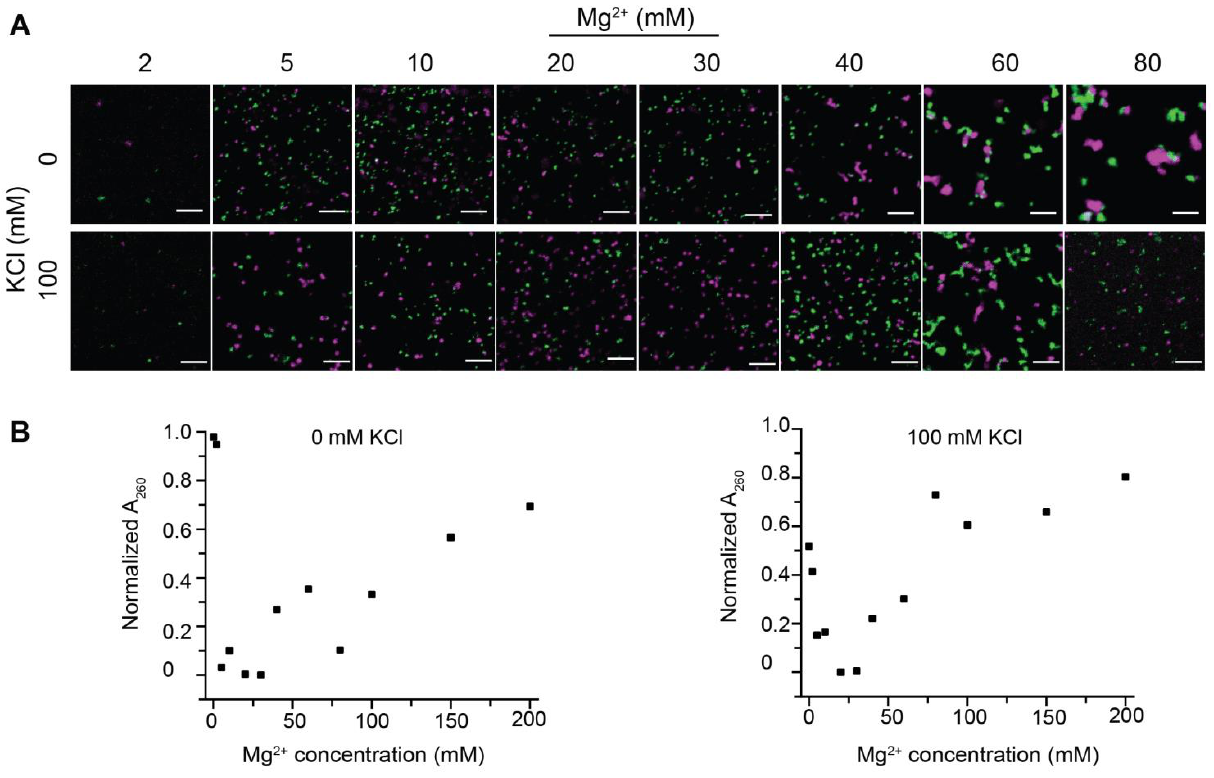
Figure 5. Two-color mixing assay characterization of the solid-like aggregation of 62-202-601 nucleosome arrays. ( A ) Confocal fluorescence microscopy images of samples at conditions with various KCl and MgCl 2 concentrations are displayed. Nucleosome arrays containing histone H2B T116C labeled with AF488 (green) or AF647 (purple) are treated with phase separation buffer separately and were incubated for 30 min before mixing. Then, the mixture was incubated for another 20 min before imaging. The array concentration is 375 nM. ( B ) Precipitation assay characterization of 62-202-601 nucleosome arrays. The percentage of arrays in the supernatant after centrifugation (10,000 × g for 5 min) are calculated by the normalized absorbance at 260 nm. Scale bar represents 5 μ m.